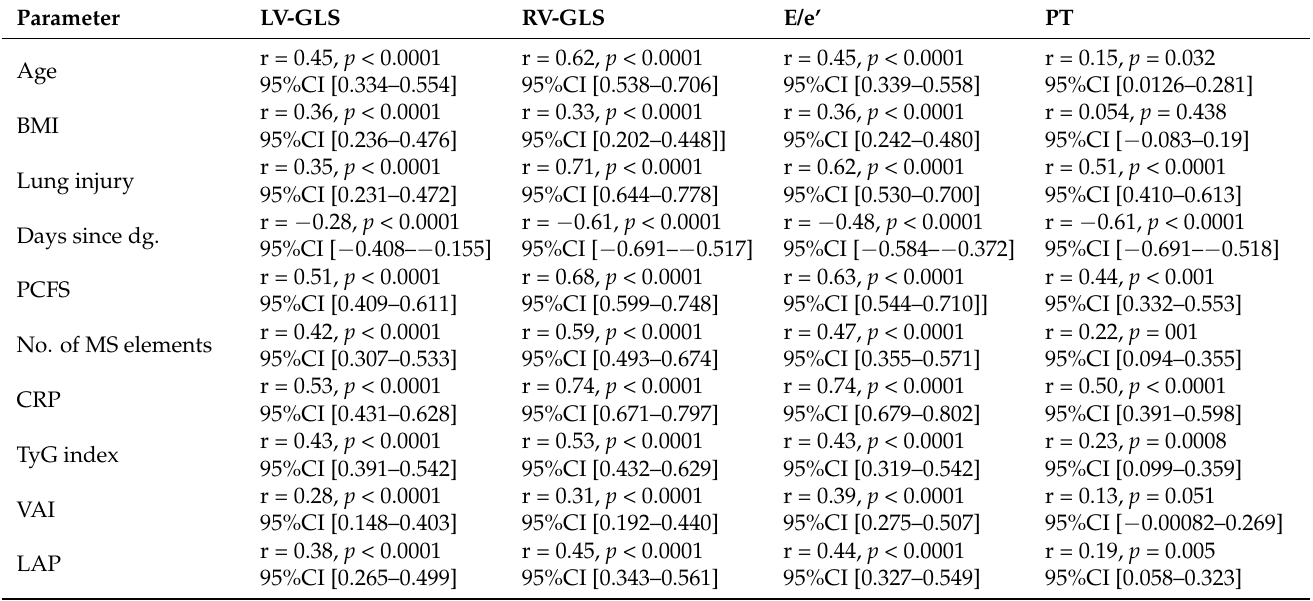
Table 4. Associations between the TTE parameters and several clinical and biological